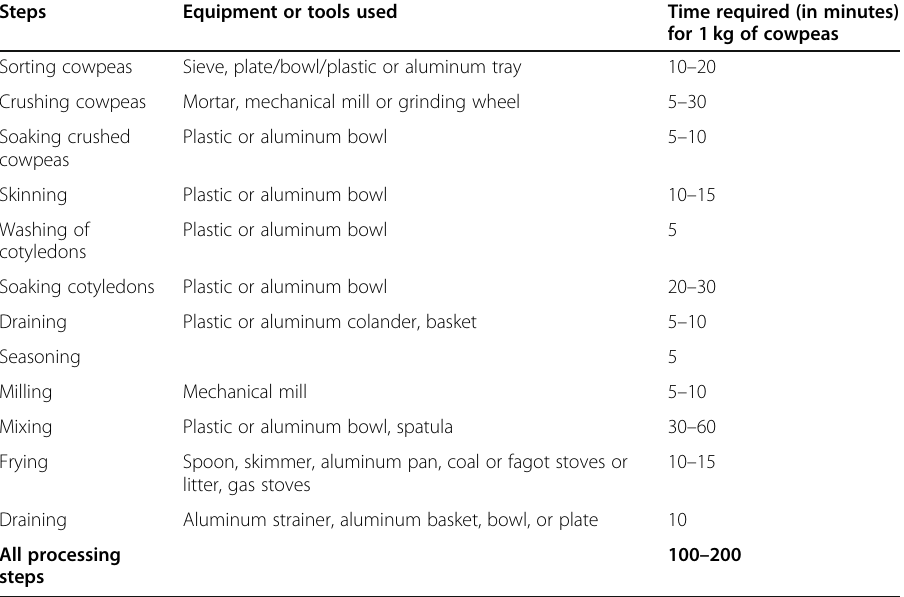
Equipment or tools